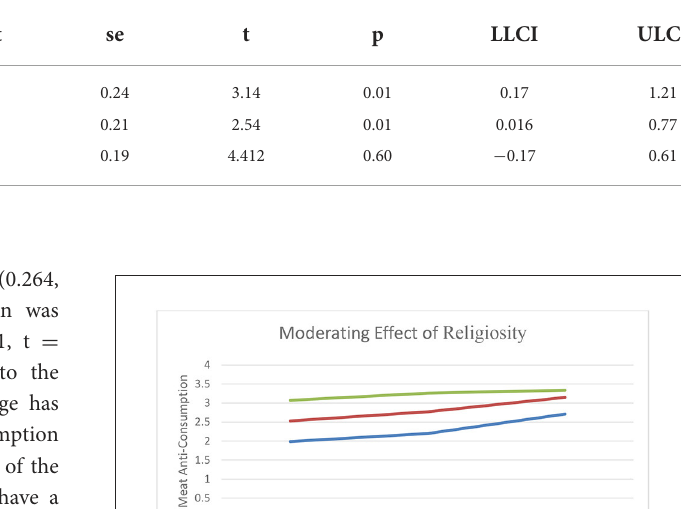
TABLE 4 Conditional effect of (IF) on (MAC) at different value levels of the moderator (RC).